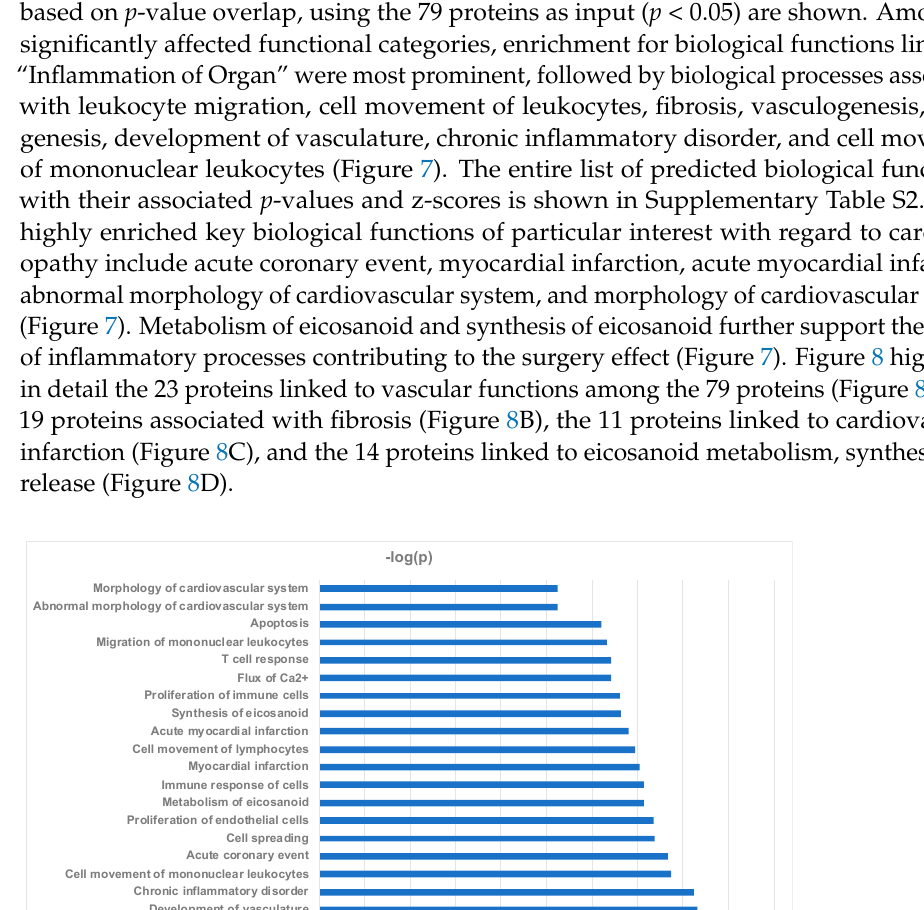
( D ) Figure 8. Biological functions linked to altered plasma protein profiles after surgical myectomy with predicted protein interactions. ( A ). Biological network linked to vascular function. ( B ). Biological network linked to fibrosis. ( C ). Biological network linked to myocardial injury. ( D ). Biological network linked to eicosanoid metabolism. Red indicates upregulation and green denotes downregulation in ‘post’. Proteins are coded by shape; square—cytokine, vertical rhombus—enzyme,